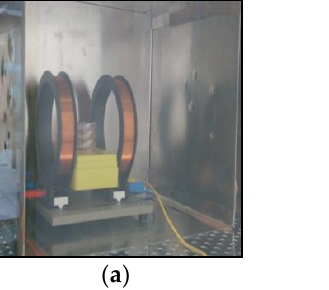
Figure 1. The extremely low frequencies-electromagnetic field (ELF-EMF) system: (a) a pair of Helmholtz coils inside a mu-metal box; (b) the scheme of a pair of Helmholtz coils, where P is the point placed in the center of the axis, d1 is the distance from Coil 1 to the point P, and d2 is the distance of the Coil 2 to the point P.